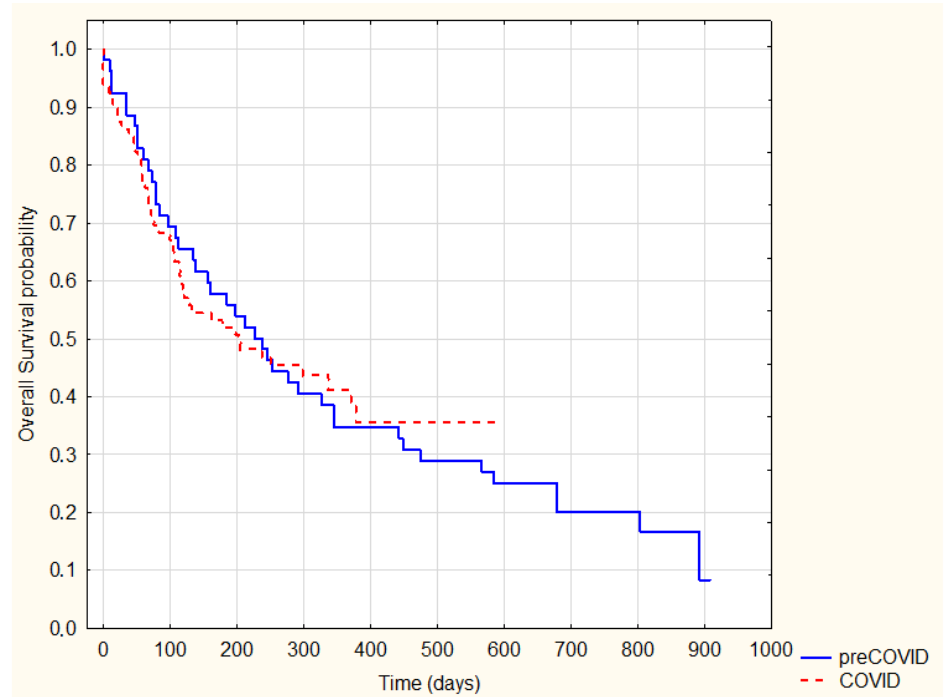
Figure 7. Kaplan–Meier Survival Analysis—squamous cancer pre-COVID-19 vs. COVID-19, log-rank p = 0.83.